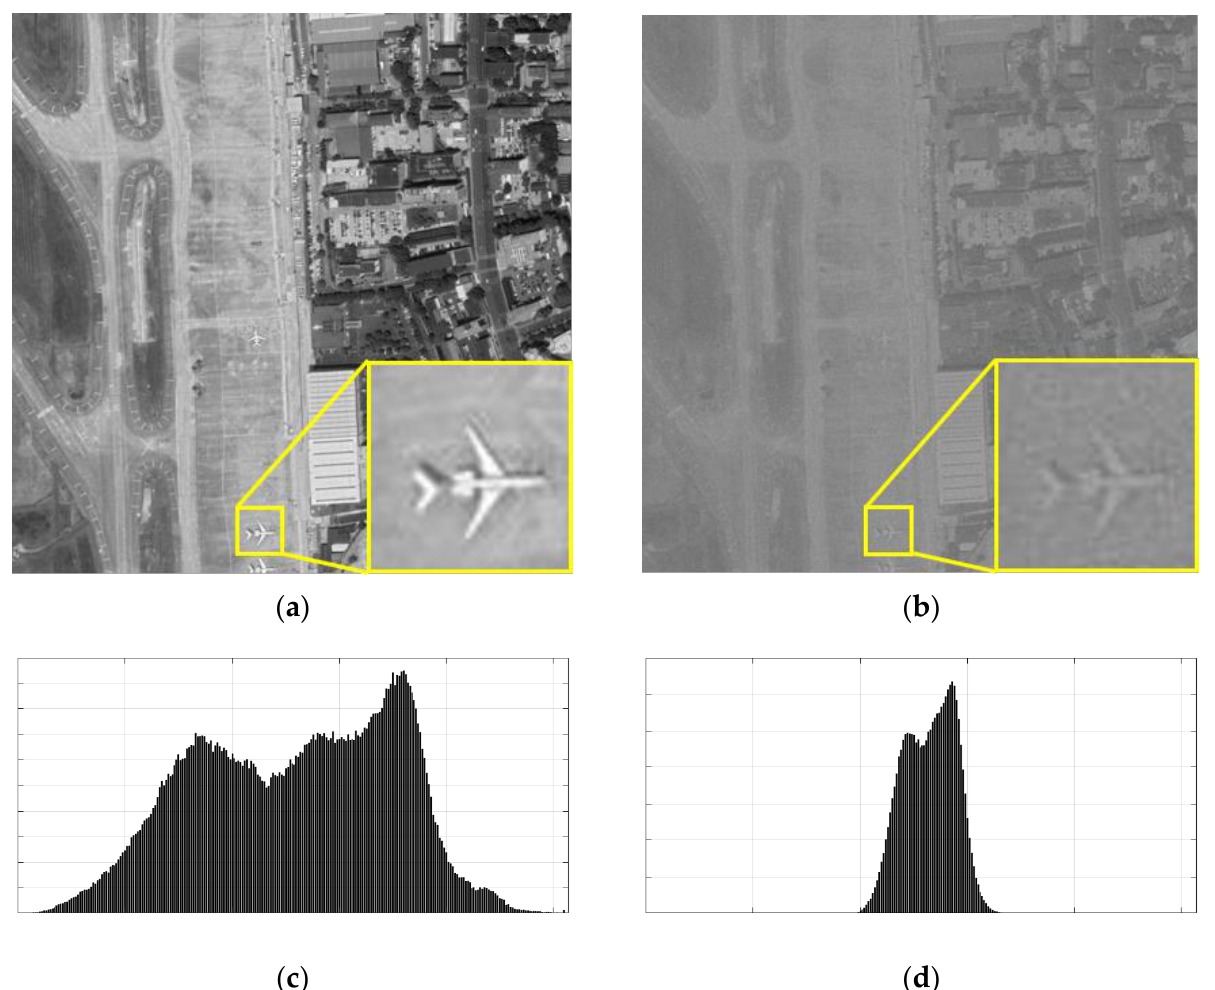
Figure 1. Comparison of an ordinary RSI and an SNR RSI: ( a ) the ordinary RSI, ( b ) the low SNR RSI, ( c ) histogram of the ordinary RSI, ( d ) histogram of the low SNR RSI. Meanwhile, the aircrafts are presented as small targets and sparse samples relative to the background in broad width high-resolution RSIs. In addition, under the condition of low SNR, the aircraft saliency is reduced, and the target details become fuzzier with the interference of high frequency noise, which greatly increases the difficulty of target detection. Nevertheless, the existing target detection algorithms in remote sensing are mainly aimed at general targets with sufficient sample size, which lack a treatment scheme for the small targets represented by aircrafts under the brand new imaging system with an ultra-large area-array